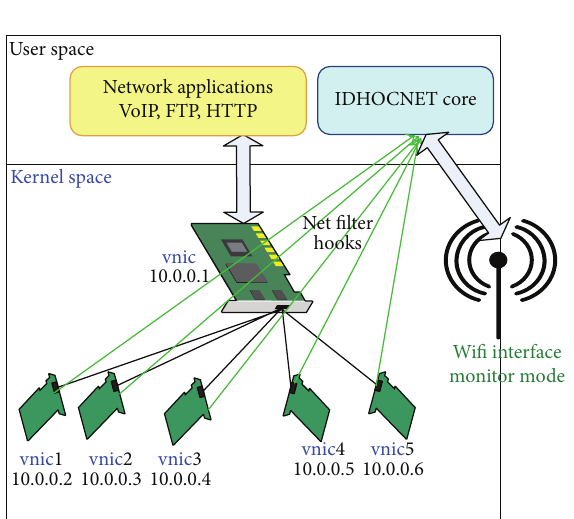
Figure 14: Localized IP address mapping with